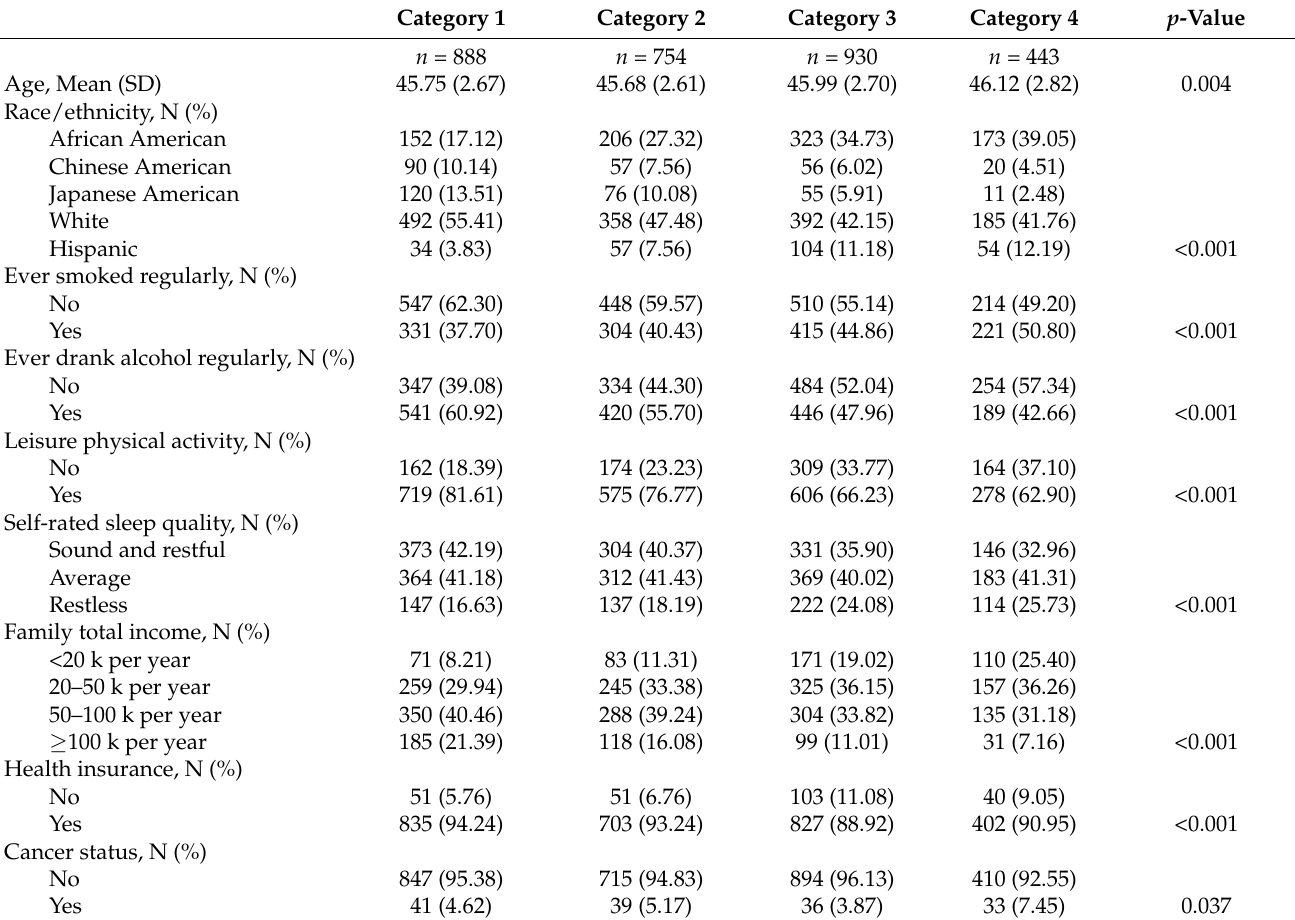
Table 3. Demographic, healthy behaviors, socioeconomic status, and support by AL category.